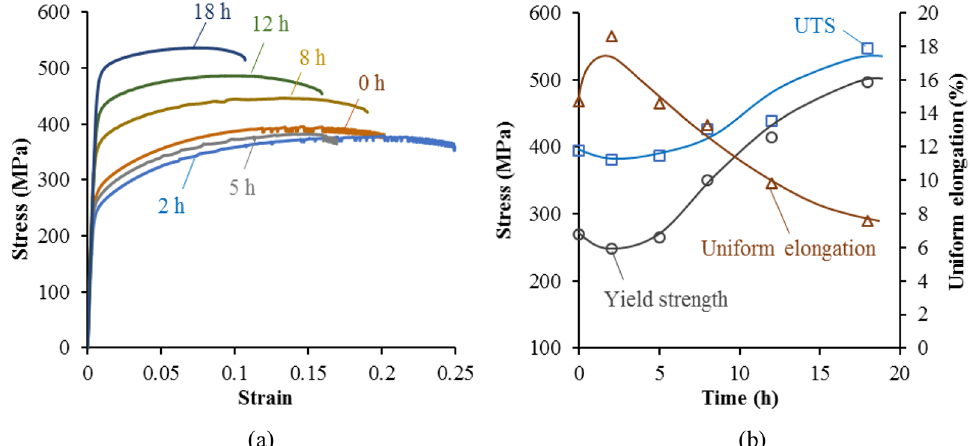
Fig. 5. (a) Stress – strain curves for AA2050-T34 alloy creep-aged under 150MPa at 155 ° C with indicated durations and (b) evolutions of yield strength, UTS and uniform elongation of the creep-aged